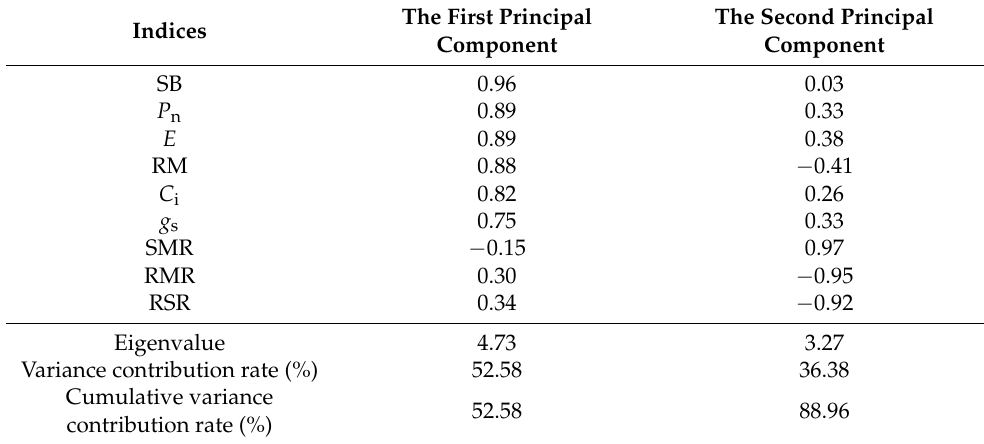
Table 3. Principal component analysis of R. pseudoacacia characteristics. SB: sapling biomass; RM: root mass; RMR: root mass ratio; SMR: stem mass ratio; RSR: root–shoot ratio; P n : maximum net